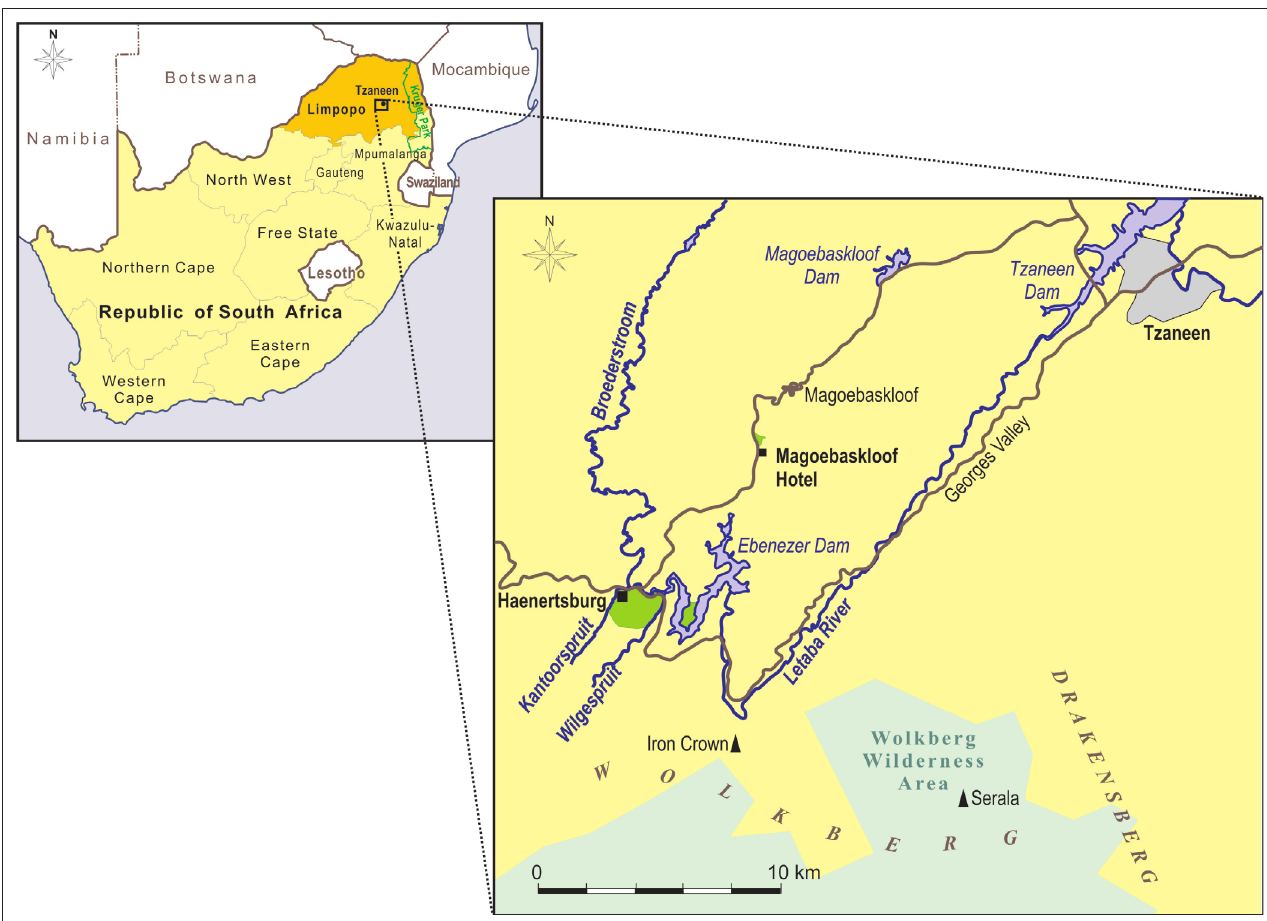
FIGURE 1: Haenertsburg town with Woodbush Granite Grassland patches (in green) located in the foothills of Wolkberg Wilderness area, northern Drakensberg escarpment, Mopani District, Limpopo Province, South